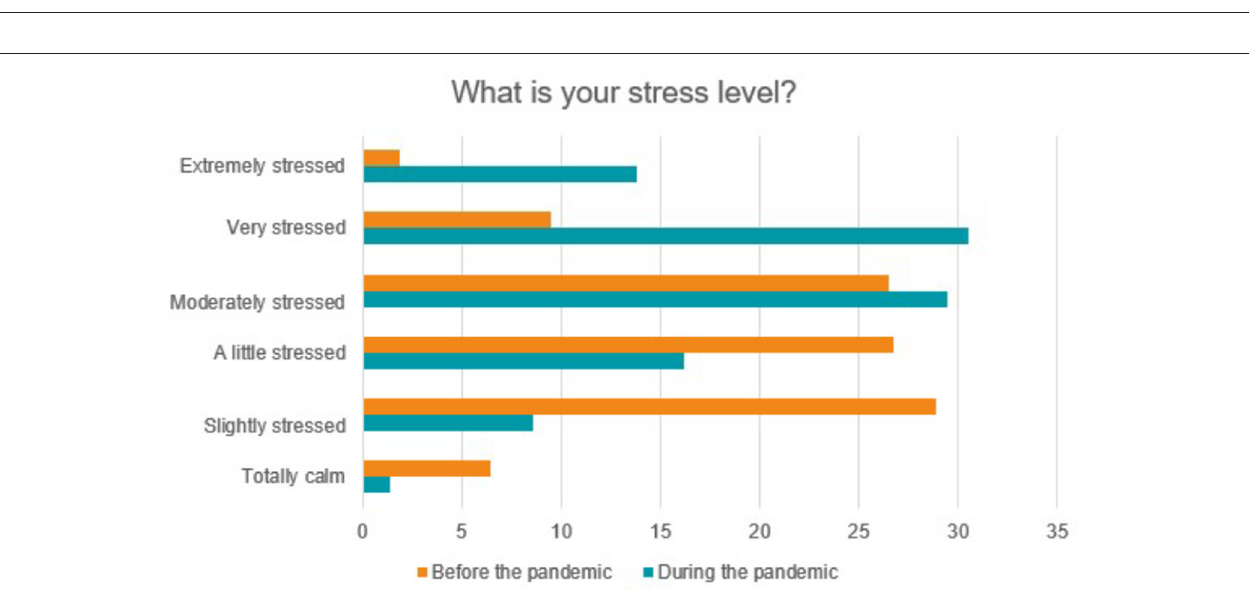
FIGURE 4 | Stress level before and during the